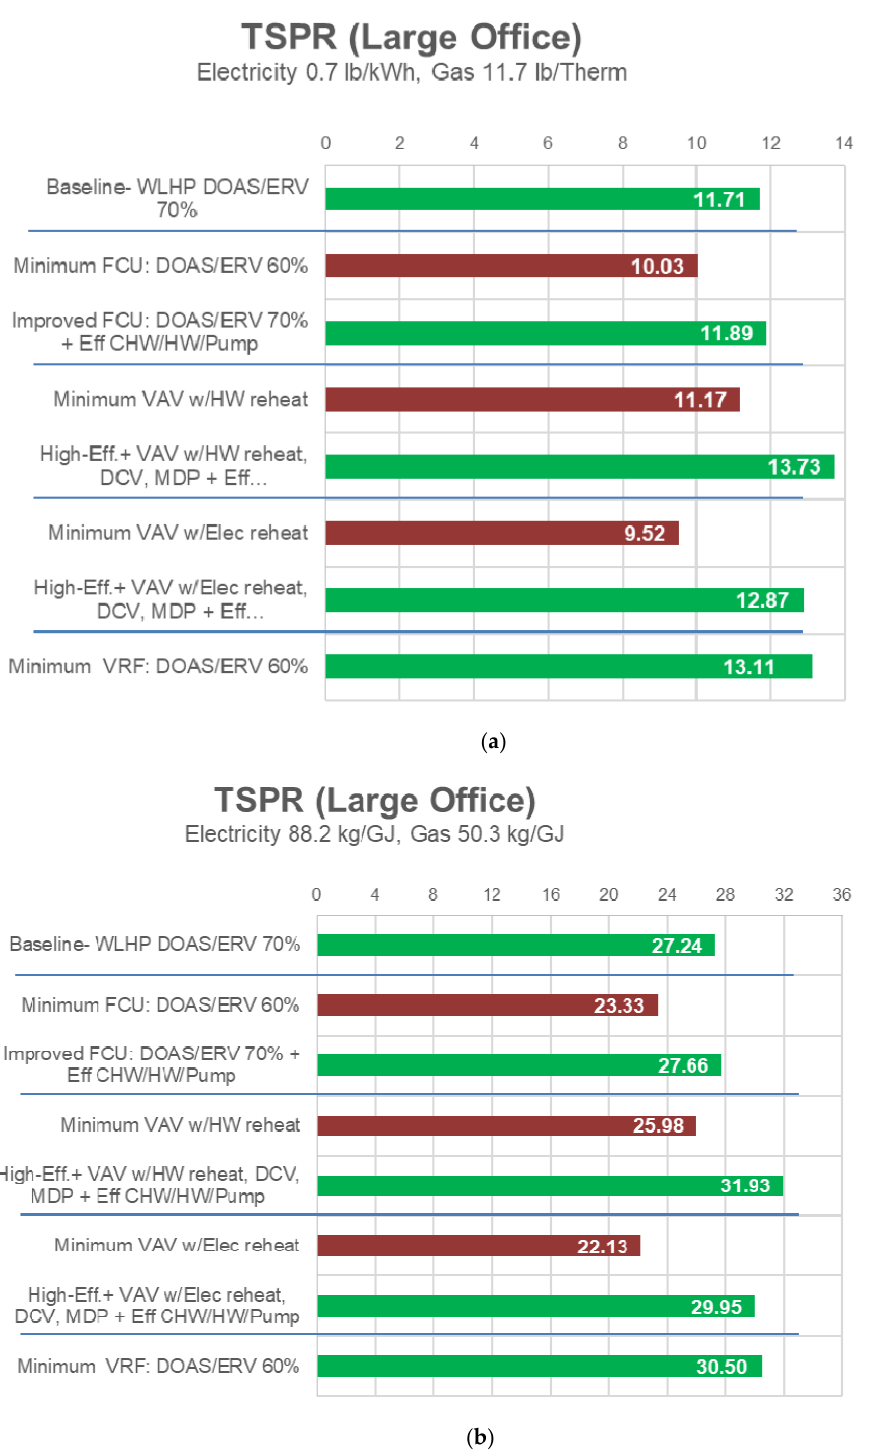
Figure 7. Results for a large office building analyzed using TSPR tool. ( a ) IP units; ( b ) SI units.